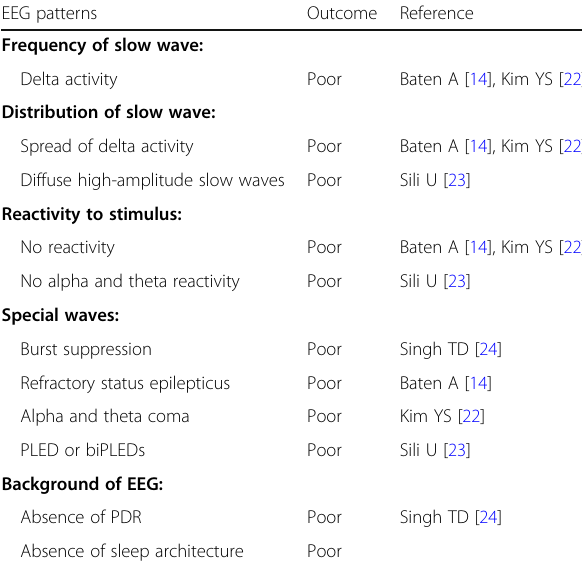
Table 1 Various EEG patterns associated with a poor outcome in